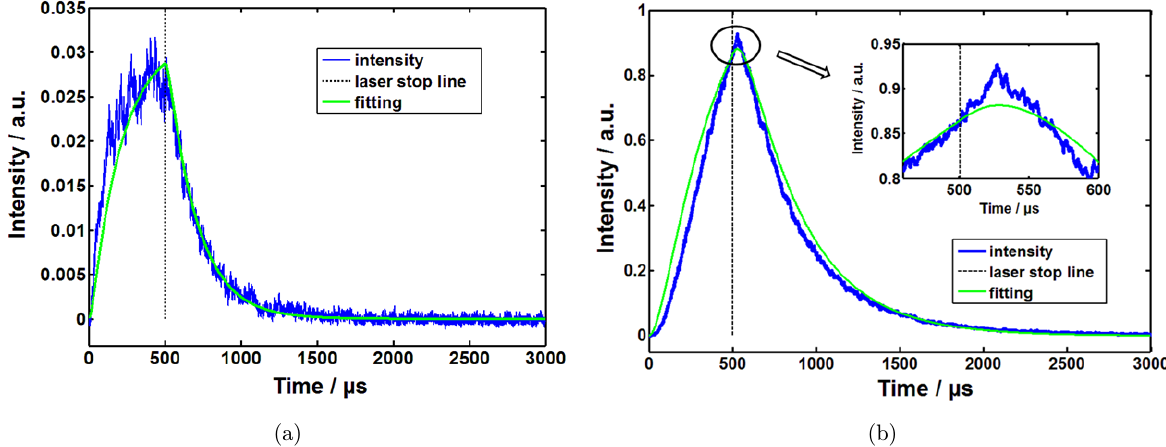
Fig. 4. Time domain luminescence intensity for single UCNP (a) and densely packed UCNPs